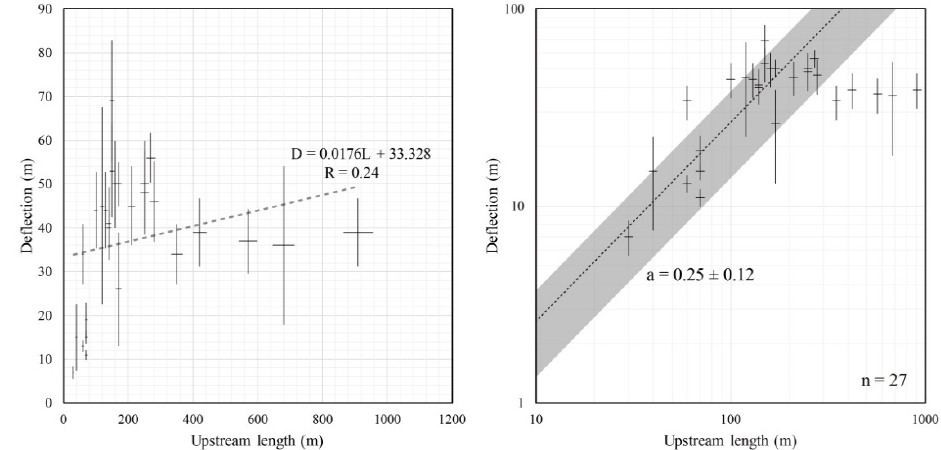
Figure 10. Diagram showing the relationship between the deflection amount (D) and the upstream channel length (L) of non-bedrock channels. Twenty-seven channels with upstream length from ~30 to ~910 m have been offset for 7 to 69 m, showing poor linear relationship between L and D (the left one is linear coordinate system, and the right one is double logarithmic coordinate system).